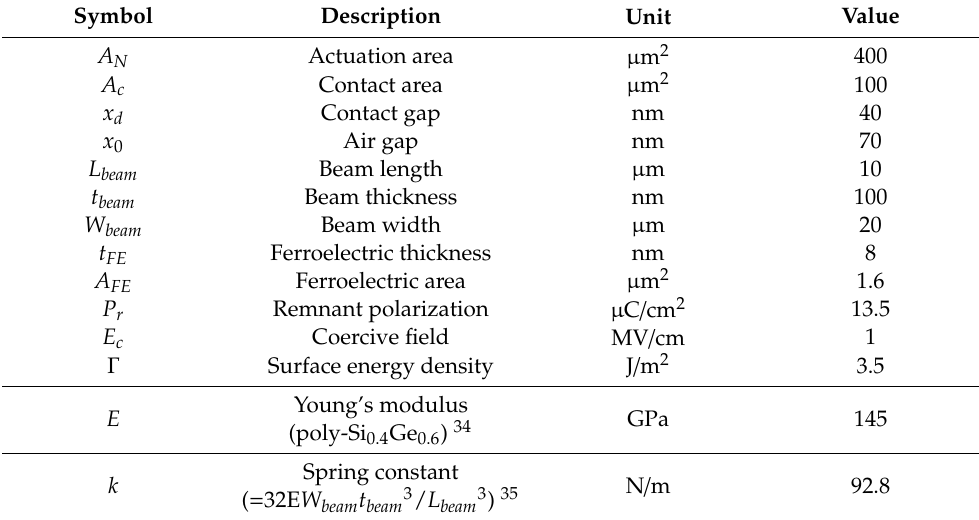
Table 1. Modeling